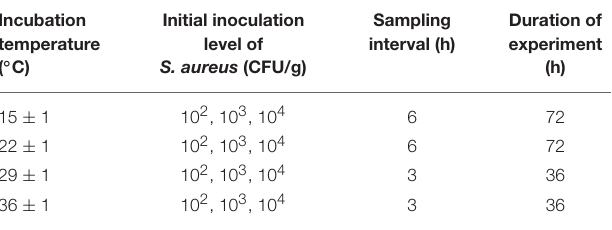
TABLE 1 | Environmental factors and experimental design for modeling the TTD of SEA in cooked chicken product.